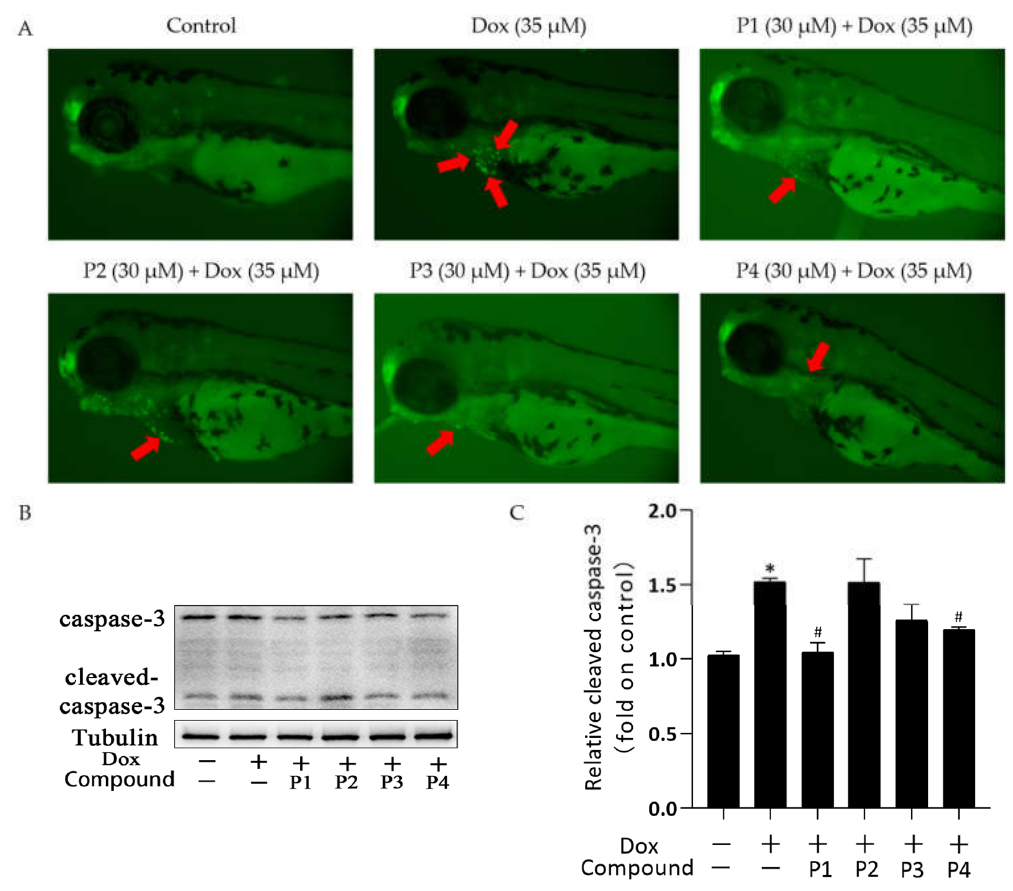
Figure 4. Effects of Hippophae rhamnoides L. phenylpropanoids on Dox-induced apoptosis in zebrafish. ( A ) Apoptosis of zebrafish cardiomyocytes observed using acridine orange staining (Arrows indicate apoptotic staining). ( B ) Cleaved caspase-3 protein expression using western blotting. ( C ) Column chart of the quantitative analysis of cleaved caspase-3 protein expression in zebrafish. * p < 0.05 vs. the control group; # p < 0.05 vs. the Dox group.